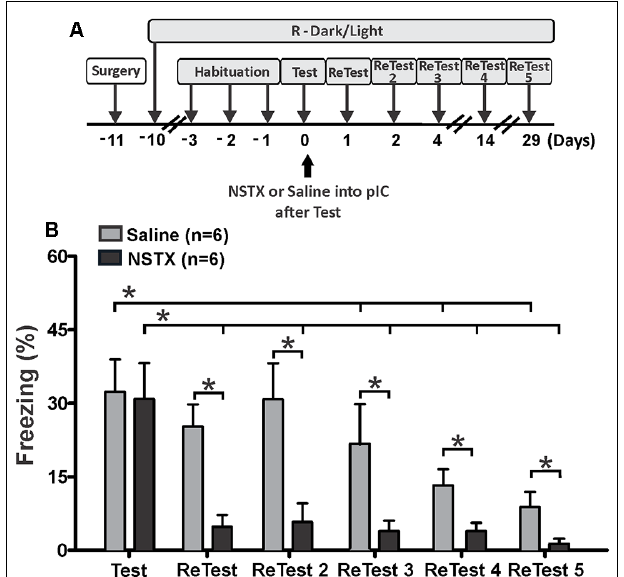
FIGURE 4 | The pIC inactivation with neosaxitoxin (NSTX) caused a prolonged reduction in conditioned freezing response. (A) Timeline of the experimental design. Immediately after the first exposure to cat odor (Test), the rats were infused with saline or neosaxitoxin (NSTX) into the pIC. In the subsequent trials [ReTest (day 1), ReTest 2 (day 2), ReTest 3 (day 4), ReTest 4 (day14) and ReTest 5 (day 29)], they were re-exposed to cat odor. (B) The bars show the percentage of time spent freezing. Data are expressed as means + SEM. ∗ p < 0.05.